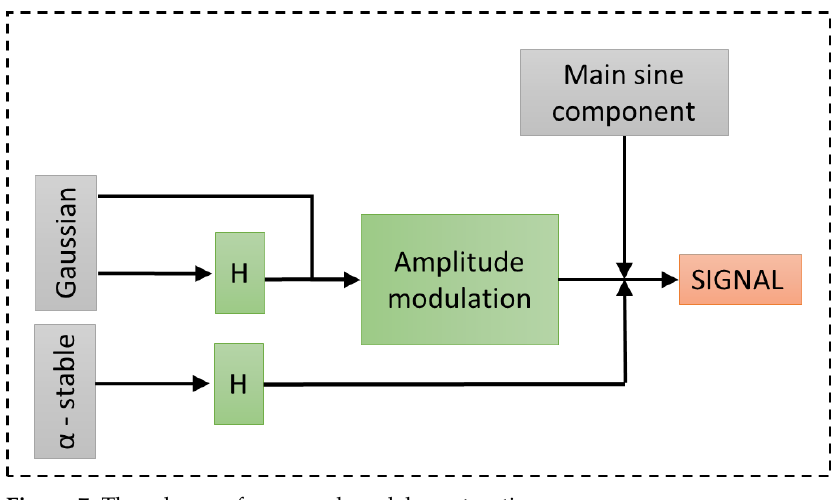
Figure 7. The scheme of proposed model